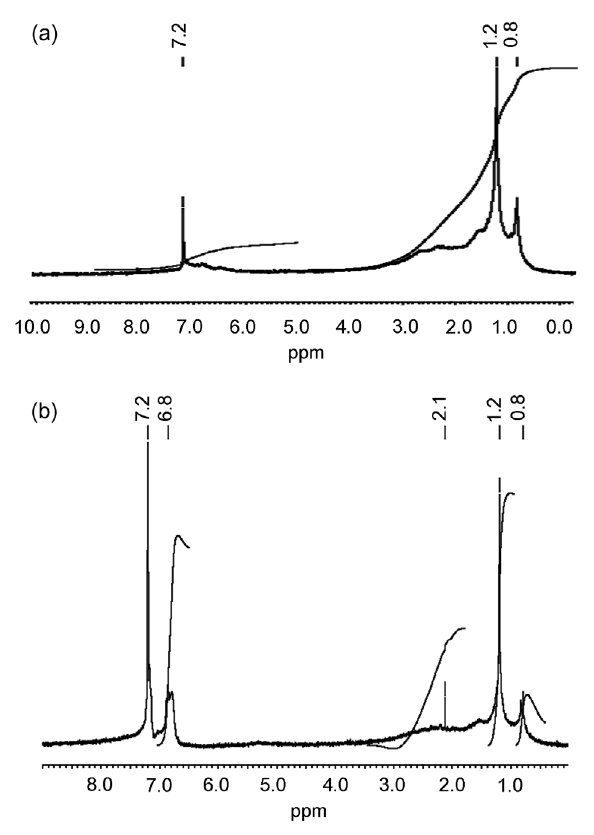
Fig. 5. 1 H NMR spectra of the pitches: (a) PHT70, (b)